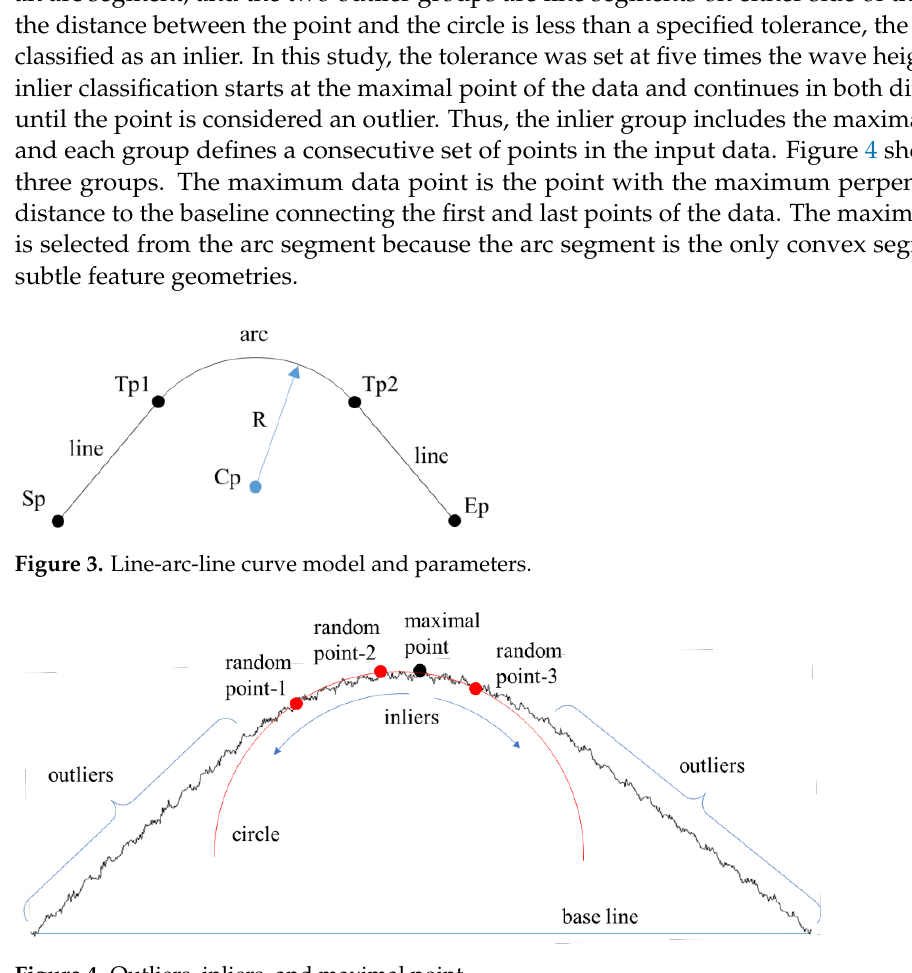
Figure 4. Outliers, inliers, and maximal point.